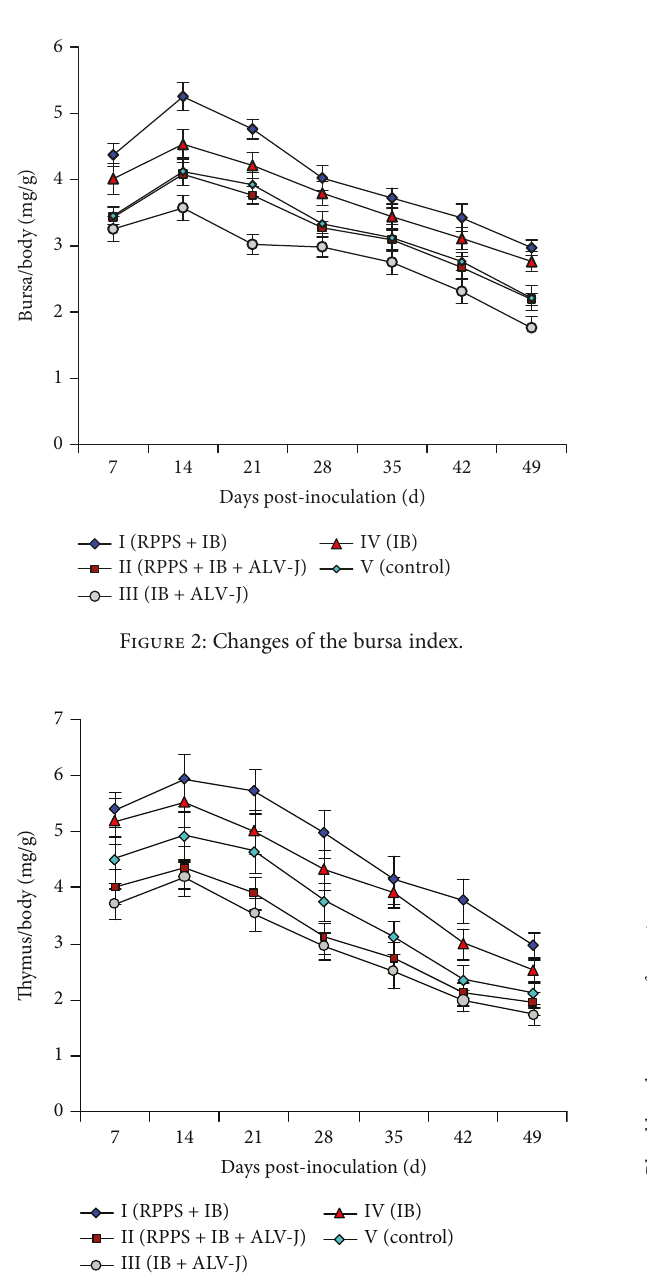
Figure 3: Changes of the thymus index.